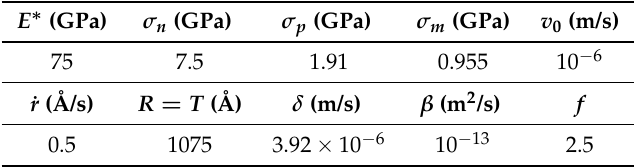
Table 1. Parameter values used for the model. The experimental parameters used are drawn from experiments on single crystals of Au [11].